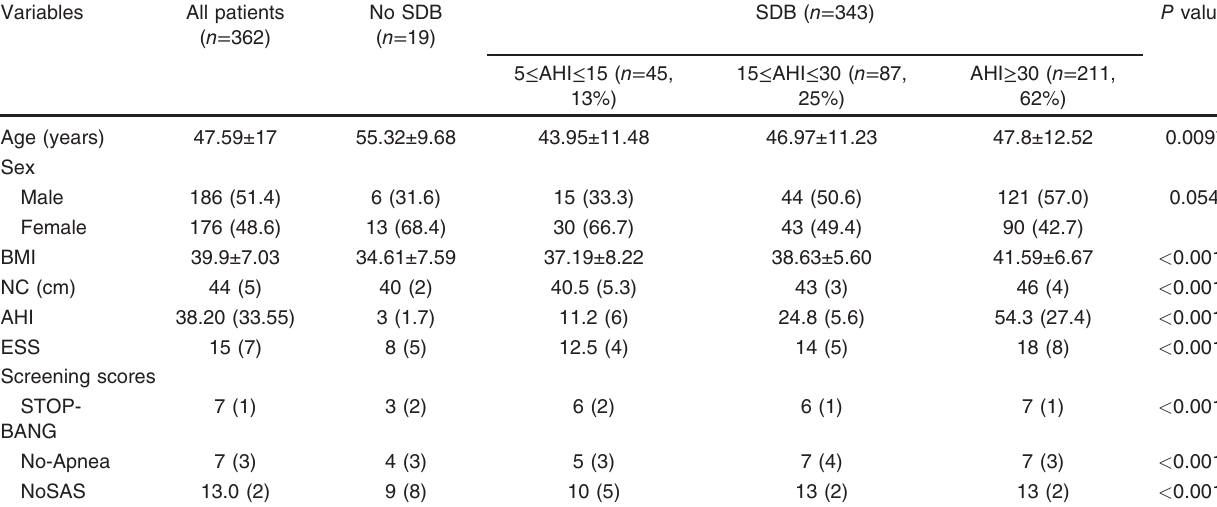
at different AHI cut-offs (5, 10, 15, 20, 25, 30), shown in Fig.2.UsingAHIatleast5or10events/hasthestandard diagnostic cut-off for SDB, the NoSAS score showed a lower AUC than theSTOP-BANG questionnaire(0.73 and 0.75 for the NoSAS score versus 0.93 and 0.85 for STOP-BANG), but higher than the No-Apnea score (0.68 and 0.73, respectively). At AHI of at least 15, the referred to our sleep lab for PSG. NoSAS score showed better performance (AUC 0.77), but still slightly lower than the STOP-BANG Questionnaire (AUC 0.79 each). At AHI of at least 20asthediagnosticcut-offforclinicallysignificantSDB, the NoSAS score showed similar performance to the STOP-BANG questionnaire(AUC 0.77). Atall cut-off values of AHI, the NoSAS score was superior to the No- Apnea score. Table 1 Demographic data and baseline characteristics of the patients